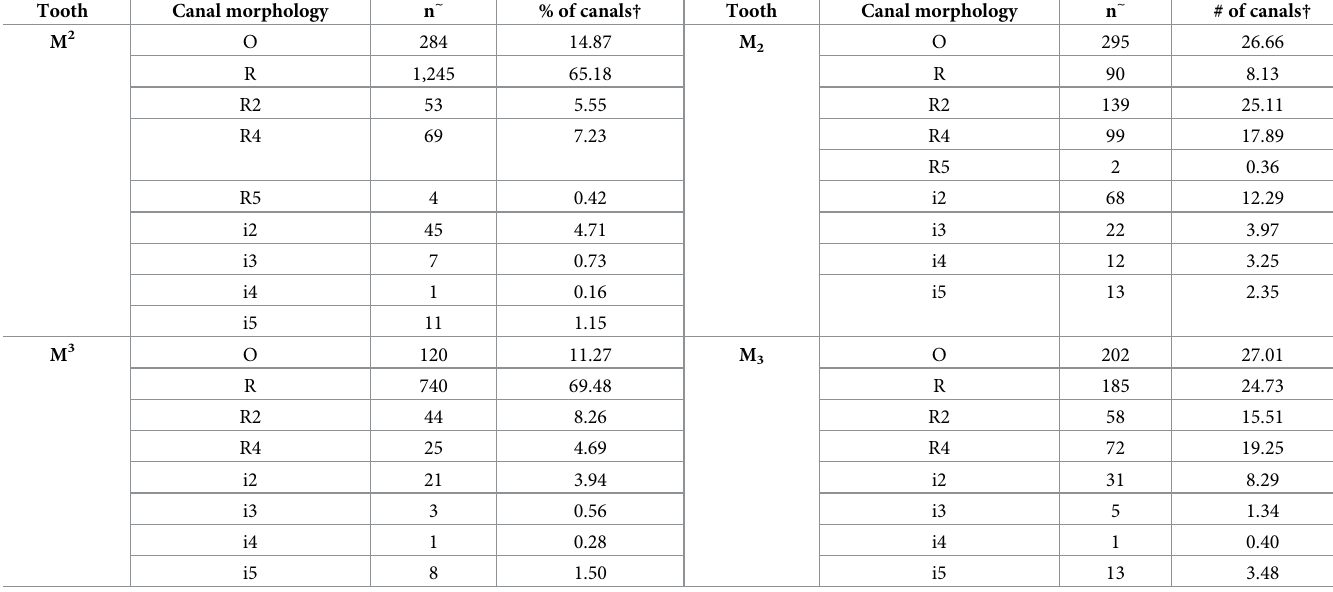
phenotype, or each of its constituent parts, individually or in any combination, is presented. Five phenotypic elements (E) that comprise the human tooth root phenotype have been out- lined: E1—root number, E2—canal number, E3 –canal location, E4—external morphology, and E5 –canal morphology and configuration. The system provides codes for each element, and the resulting combination constitutes that root complex’s complete phenotype code. Tooth name or number. This system works with categorical and numbering systems including, but not limited to, the Palmer Notation Numbering system, the FDI World Dental Federation System, simple abbreviations such as UP4 (upper 2 nd premolar) or LM1 (lower first molar), or the super- and subscript formulas described in and used throughout this study.